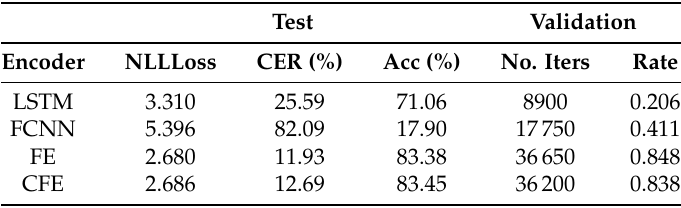
Table 6. Results obtained by the four models for the second experiment (E2). Encoder: Name of